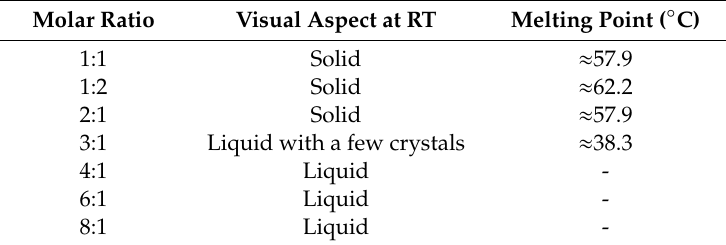
Table 1. Summary of the different POH:IBU therapeutic deep eutectic systems (THEDES) prepared in this study.